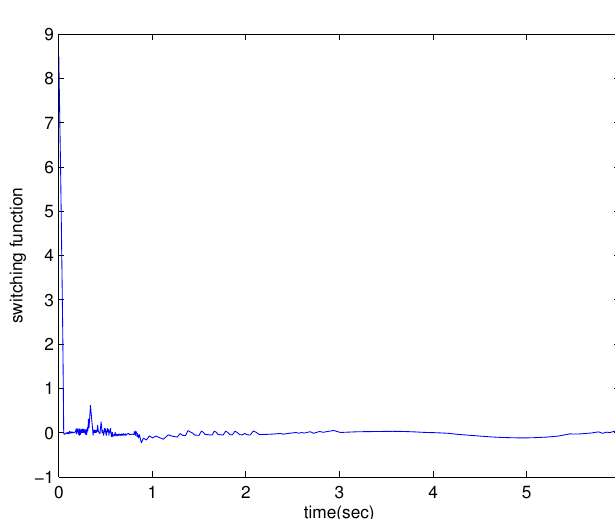
Figure 10. The switching function response